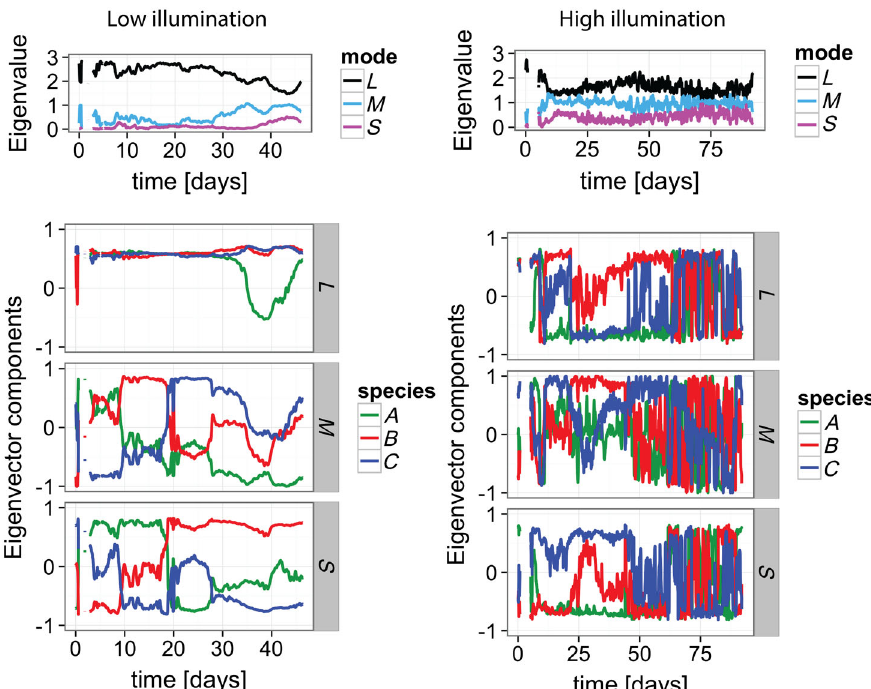
FIG. 12. Ecomodes in individual environmental conditions. Eigensystems of the correlation matrix (as in Fig. 4) for 10 CES in the low-illumination condition ( I ¼ 0 . 25 I 0 , left column) and the high-illumination condition ( I ¼ I 0 , right column). Eigenvalues are plotted in the upper panels, and eigenvector composition in the lower panels [as in Figs. 5(a) and 5(b),